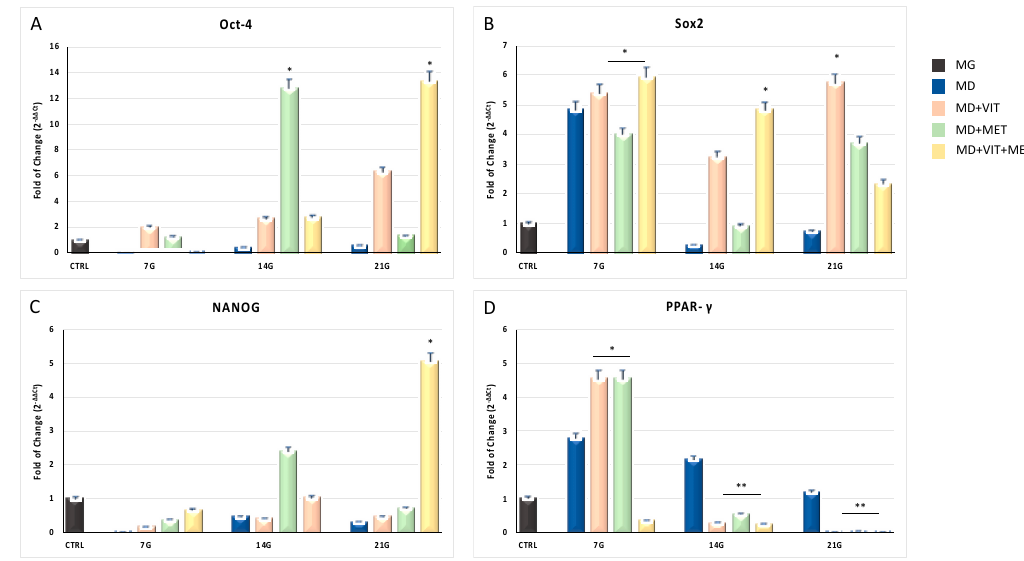
Figure 1. Expression of stemness genes and adipogenic regulating genes. The expression of stemness-related genes Oct-4 (Panel ( A )), Sox2 (Panel ( B )), NANOG (Panel ( C )) and the adipogenic regulating gene PPAR- γ (Panel ( D )), was evaluated in Adipose-derived stem cells (ADSCs) cultured in: growing medium (MG), adipogenic differentiation medium (MD) (blue bars), or in MD in the presence of vitamin D (orange bars), or in MD in the presence of metformin (green bars), or in MD with metformin plus vitamin D (yellow bars). The mRNA levels for each gene were normalized to glyceraldehyde-3-phosphate-dehydrogenase (GAPDH) and expressed as fold of change (2 −∆∆ Ct ) of the mRNA levels observed in undifferentiated control ADSCs (black bars) defined as 1 (mean ±SD; n = 6). Data are expressed as mean ± SD referred to the control (* p ≤ 0.05; ** p ≤ 0.01).